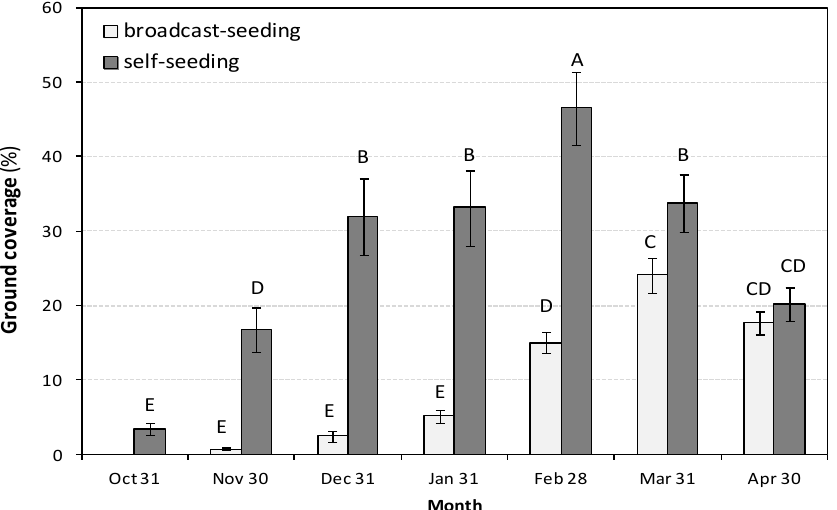
Figure 2. Change in ground coverage (%) by A. arvensis throughout its growth cycle for the two agricultural seasons evaluated, according to the sowing method (mean values). Error bars are standard error of the mean. Di ff erent capital letters indicate significant di ff erences ( p = 0.05) in monthly ground coverage between both sowing systems according to Fisher LSD